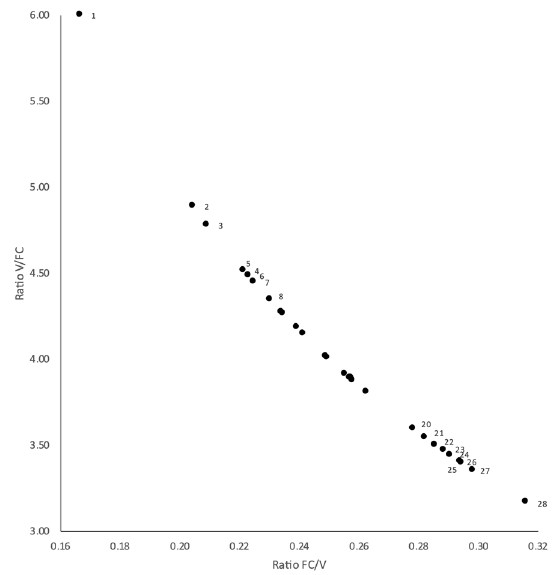
Figure 5. Projection of the FC/V and V/FC ratios. Legend: 1— Ilex aquifolium ; 2— Ruscus aculeatus ; 3—